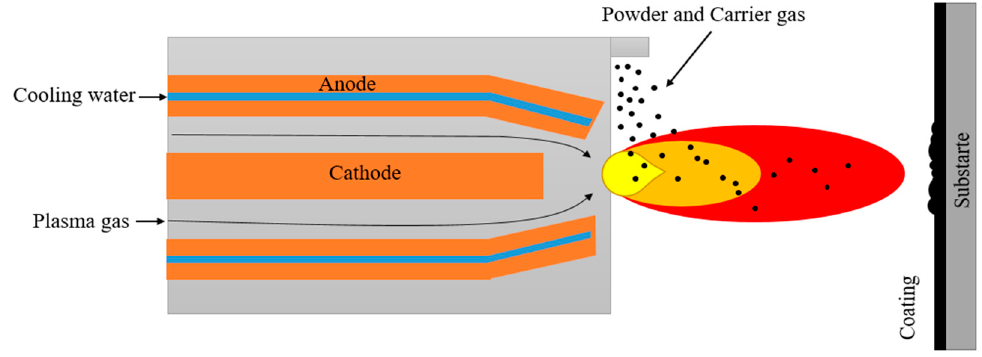
Figure 3. Schematic process of coating deposition by using thermal spray